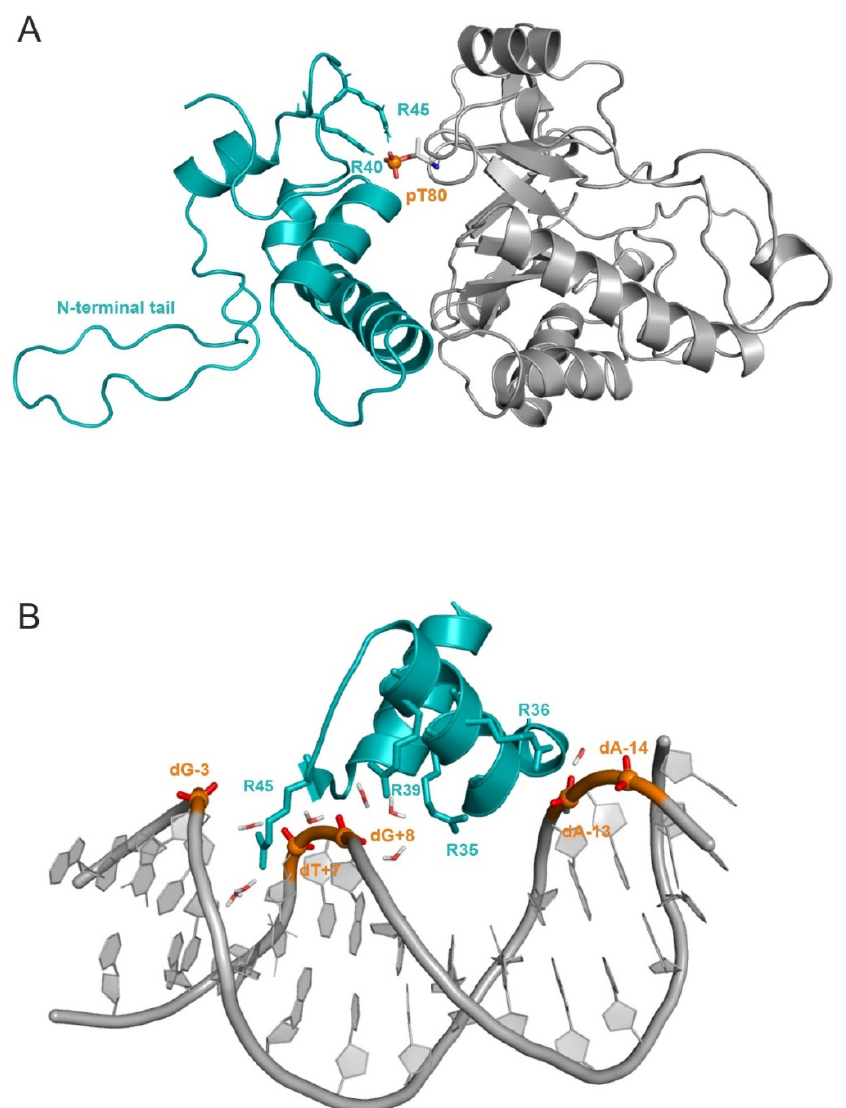
Figure 6. ( A ) Histone H4 (teal, cartoon) bound to PRMT5 (cartoon, grey) phosphorylated on T80 (pT80). Main anchoring residues, R40, R45, and pT80 are represented with sticks. MEP50 and certain parts of PRMT5 and H4 are not shown; ( B ) histone H4 (teal, cartoon) bound to DNA (grey, cartoon) in the experimental nucleosome structure (PDB code: 1kx5). An abridged structure of H4 is shown. Anchoring points are highlighted with sticks. Phosphates (orange) are represented with spheres in ( A ),( B ). In the 1kx5 structure, histone H4 and DNA are depicted as chain ID(s) F and I, and J, respectively. Note that histone H4 is embedded into the nucleosome, except for its N-terminal tail hanging out. The DNA binding domain of H4 is composed by K16-K20, based on the UniProt database (numbering according to PDB), which was identified in the nucleosome complex (1kx5), as well. However, residues before this region (Table S3) can also create interactions with DNA, due to the flexibility of the N-terminal tail. Furthermore, other H4 regions, such as R36-G48 and K79-T80, were also found to interact with DNA (Figure 1A, Table S3).